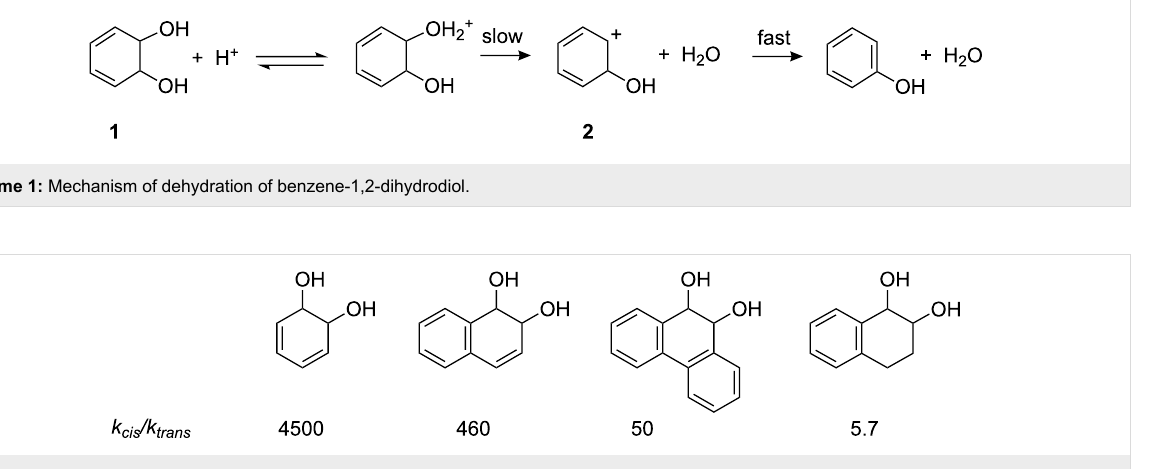
Figure 1: Reactivity ratios for acid-catalyzed reaction of arene dihydrodiols.